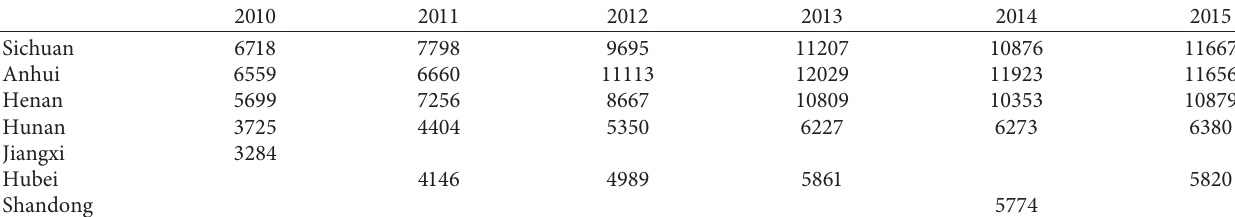
Table 4: The top 5 provinces for outflow populations in